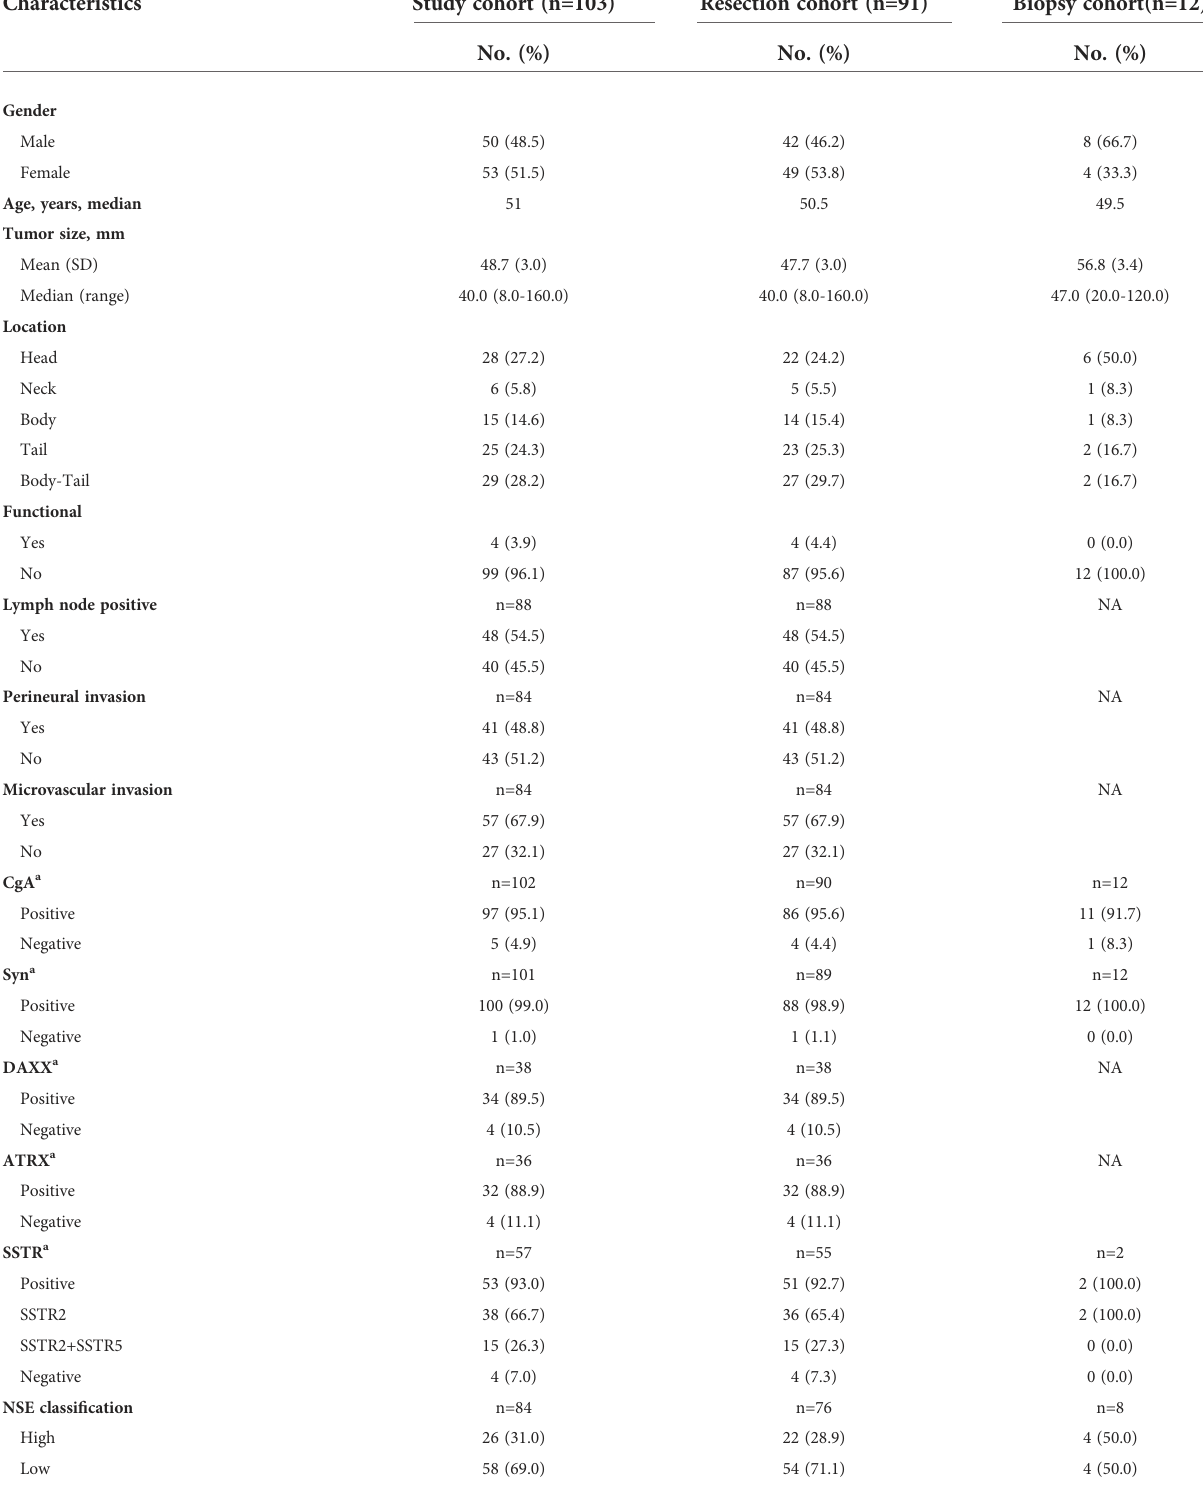
Table 1. Demographics and clinical characteristics of the study cohort, resection and biopsy